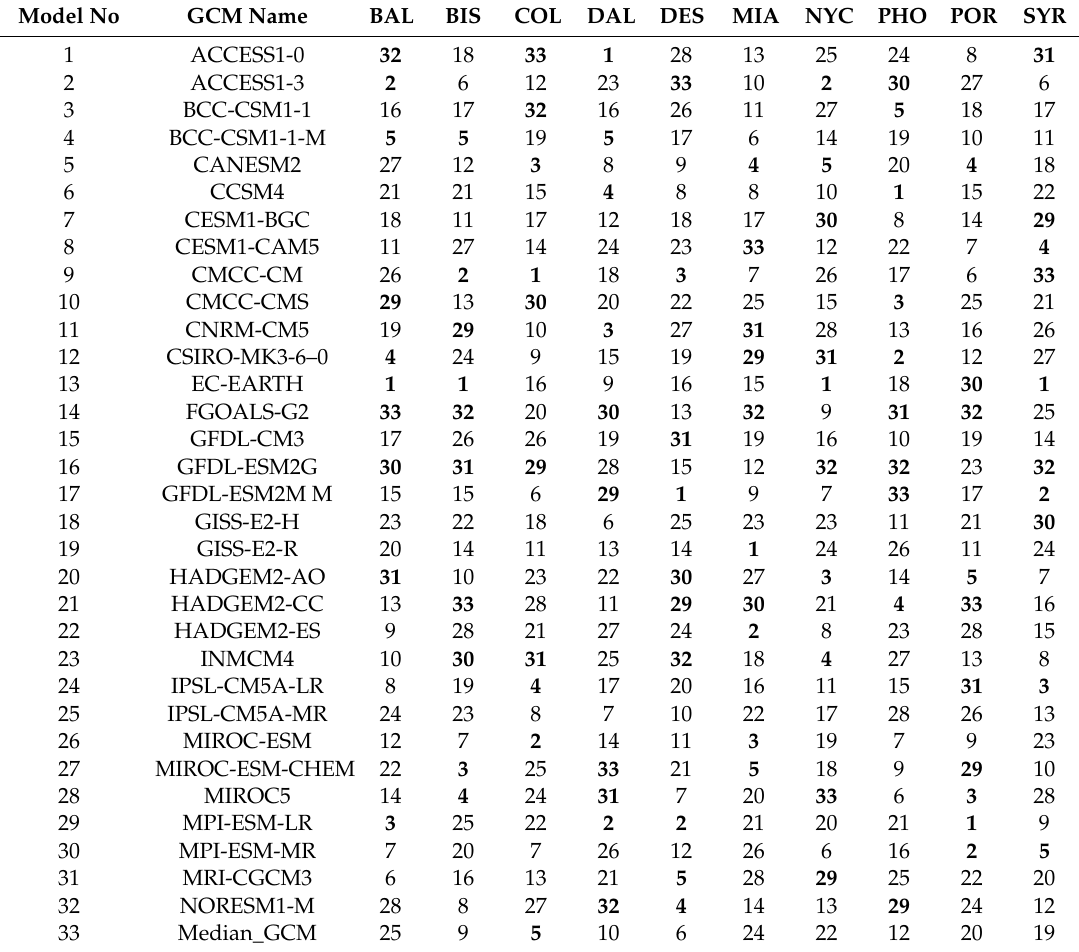
Table 3. Downscaled GCMs performance rank in the simulation of historical heat wave properties for the period 1950–2005 according to a multi-criteria decision-making (MCDM) approach on Nash–Sutcli ff e e ffi ciency (NSE) coe ffi cients. (The five best and least fit downscaled GCMs for each city are shown in bold